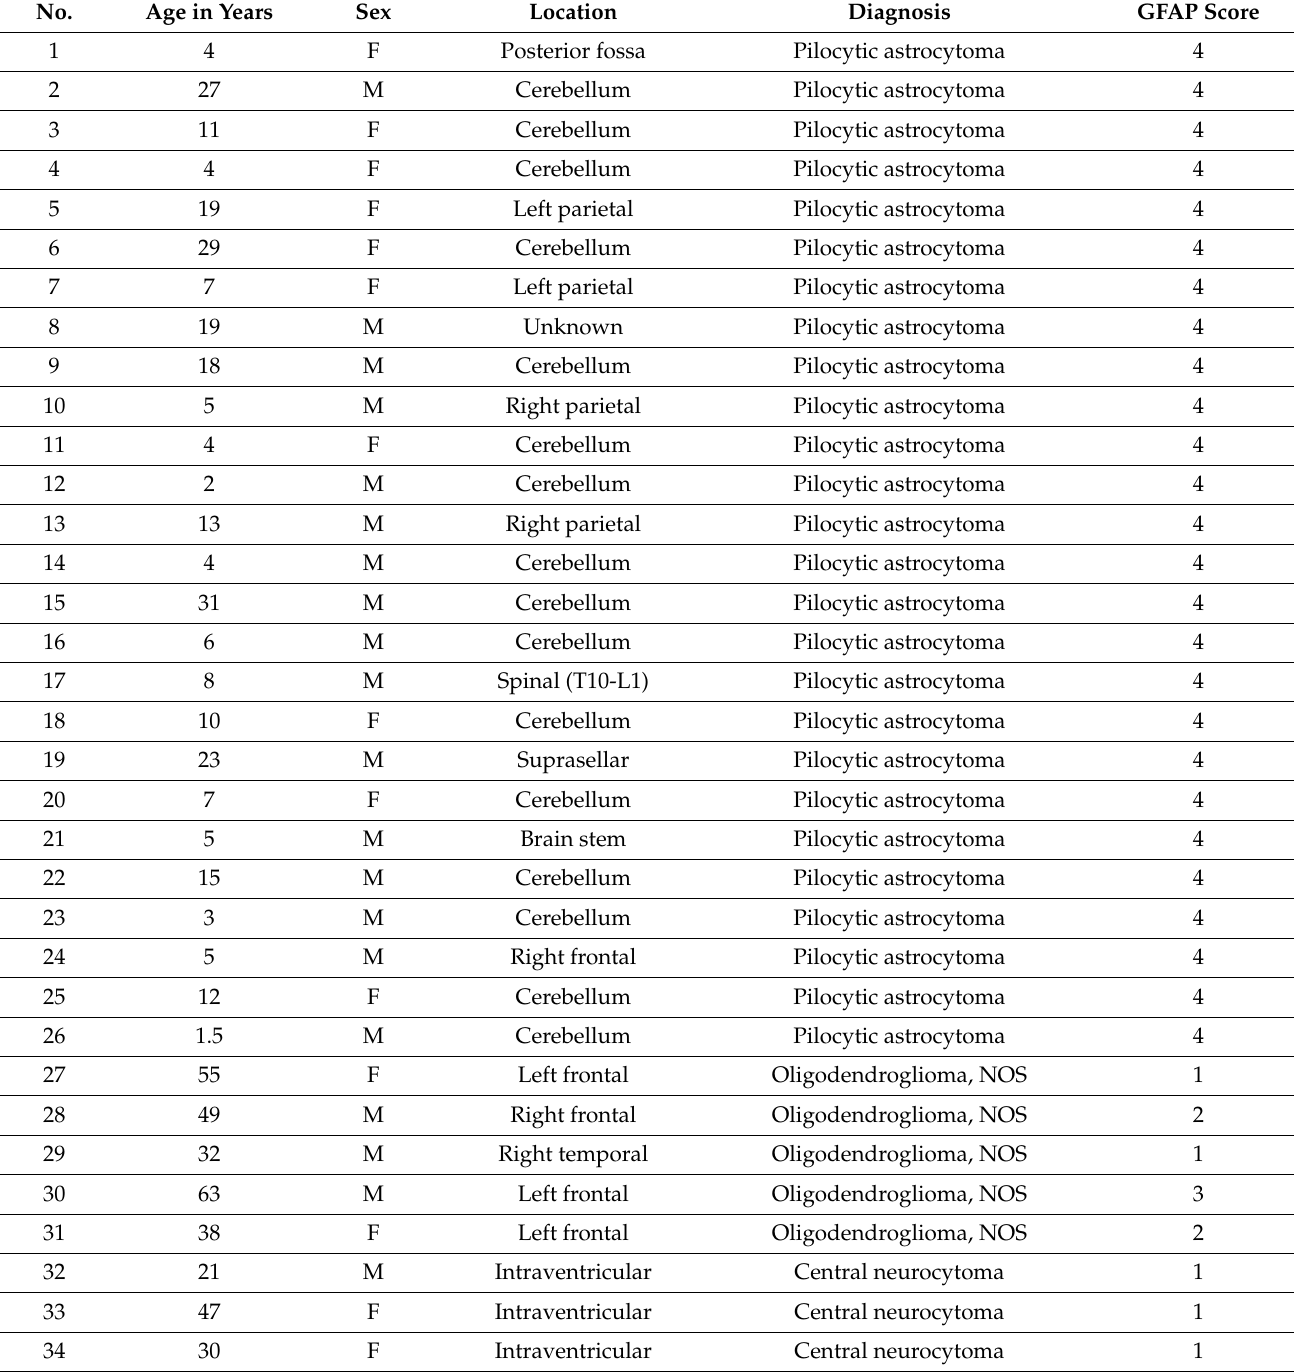
Table 1. Clinical data and GFAP staining